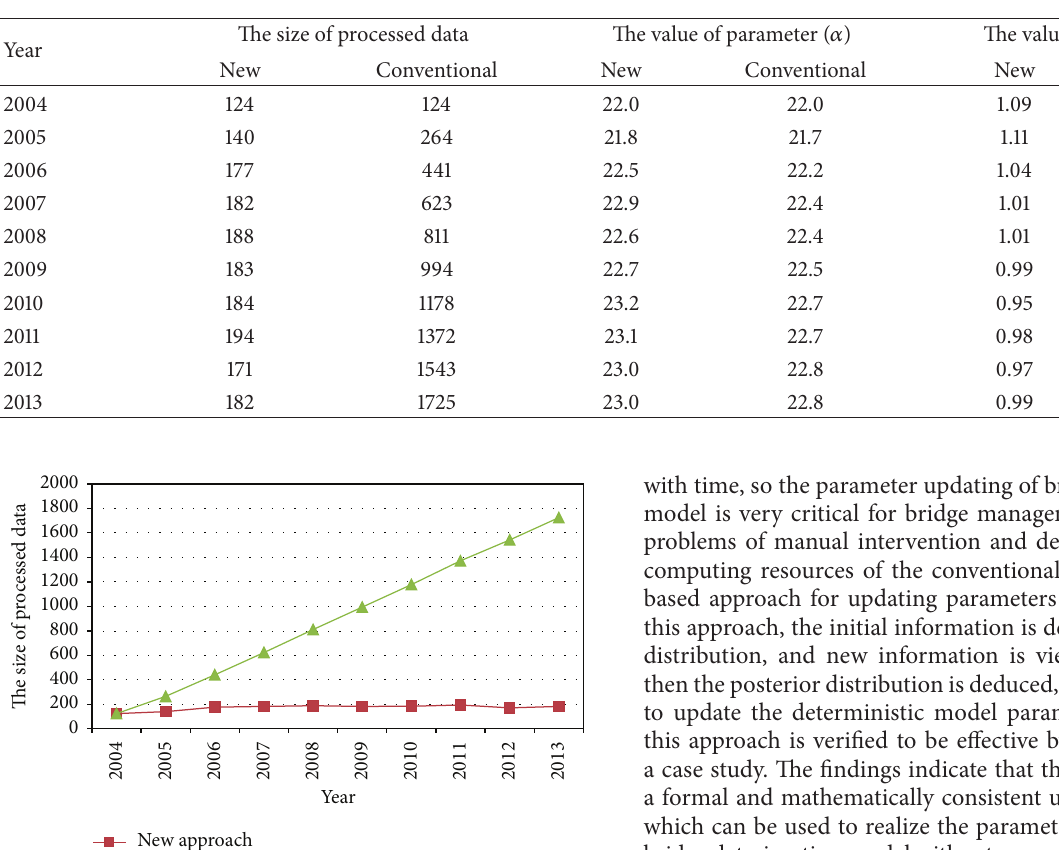
Table 2: Results of new approach and conventional approach.